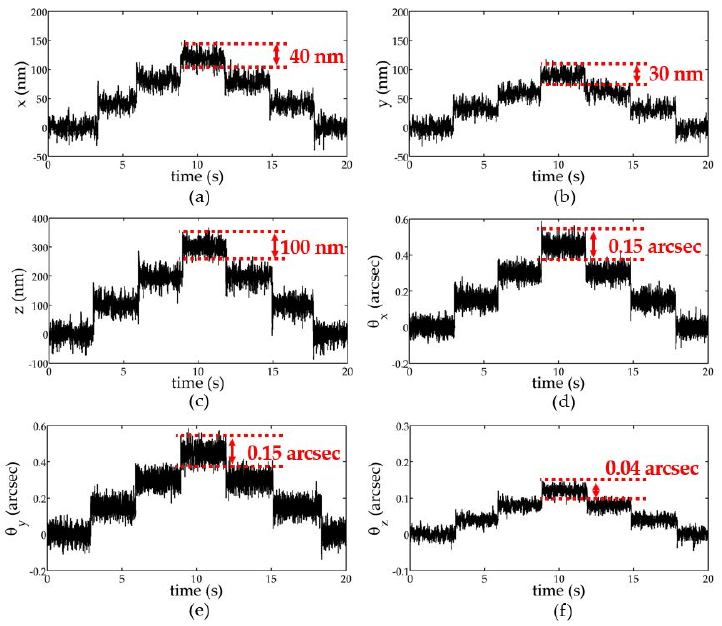
Figure 12. The evaluated minimum positioning resolution data of the dual servo stage: ( a ) x direction,